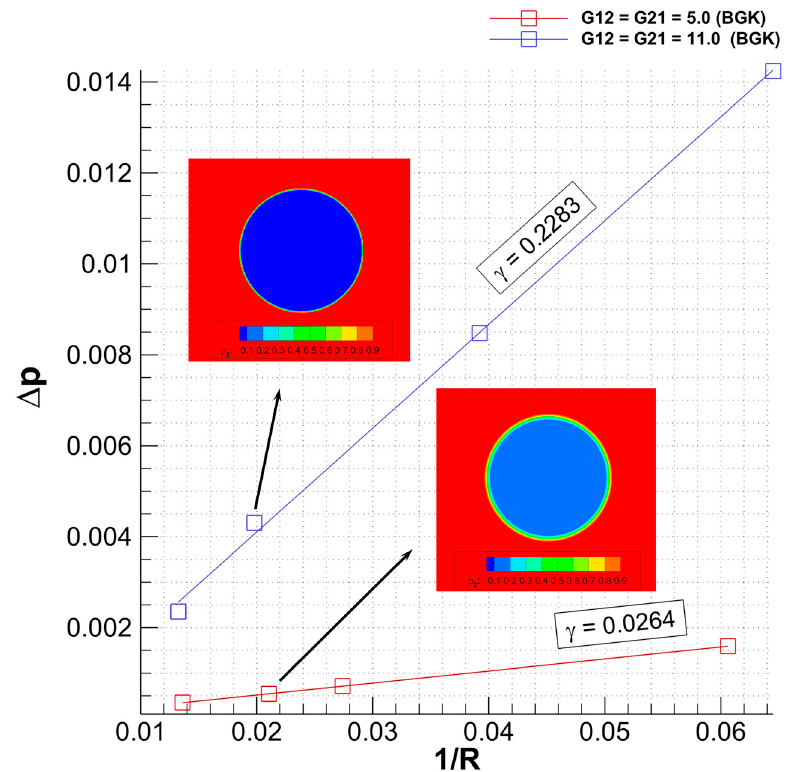
Figure 2. Young–Laplace test for the two limiting surface tension cases for density ratio ≈ 1 (single phase two components). Surface tension and density contours are presented in LU.